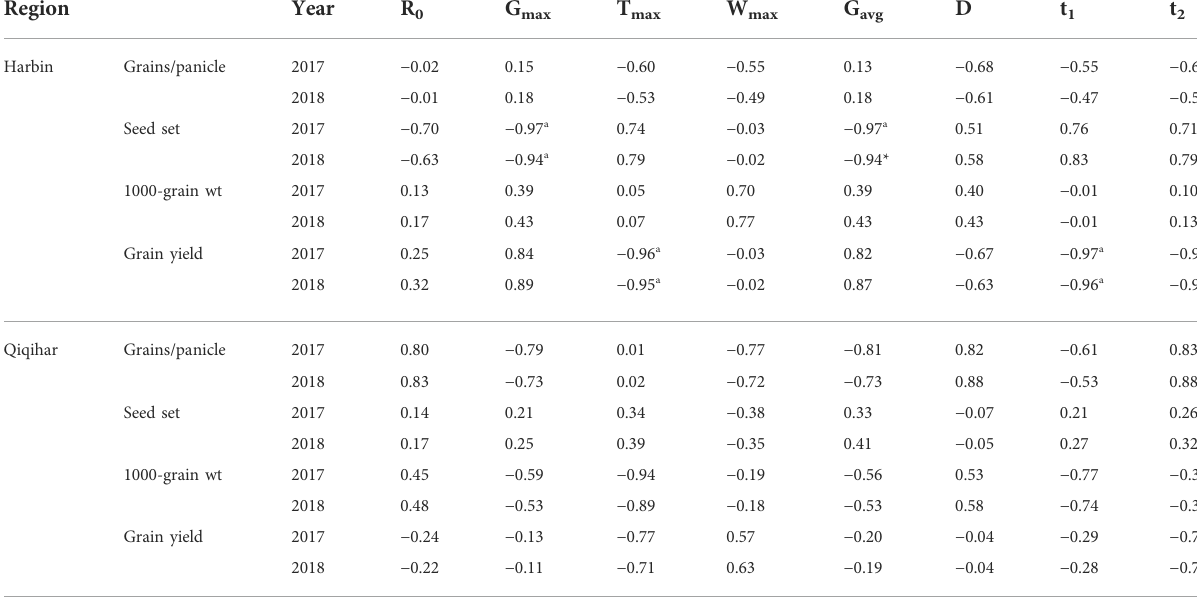
TABLE 6 Relationships between the grain- fi lling characteristic parameters of superior grains, yield, and yield components in Harbin and Qiqihar, 2017 and 2018. Region Year